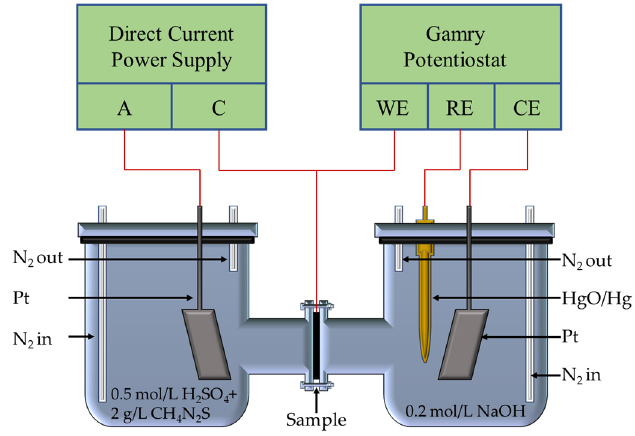
Figure 3. Schematic diagram of the electrochemical hydrogen permeation cell.